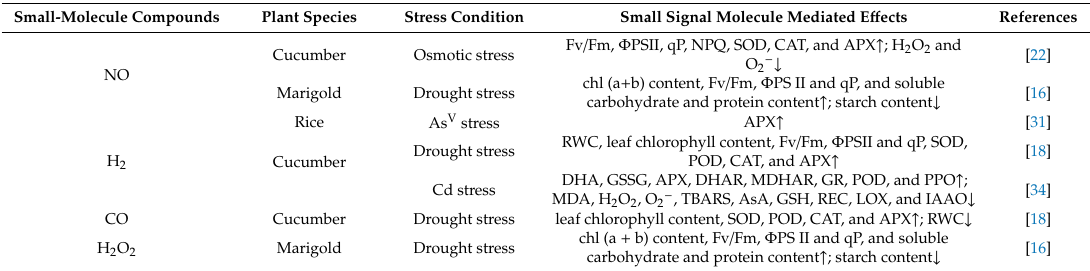
Table 2. Overview of small-molecule compounds that induce AR formation and development under stresses in